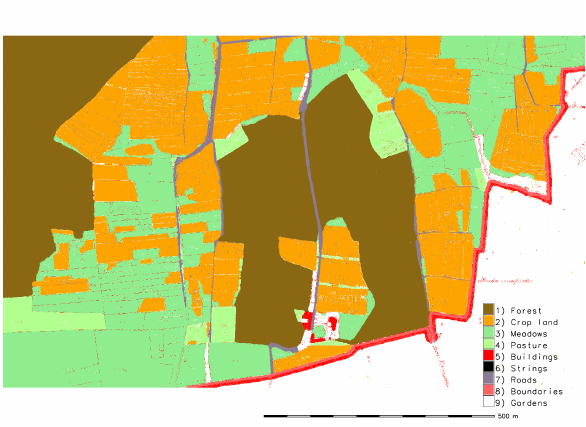
Figure 9. Classified map for supervised MLC after text and symbols removal - particular.